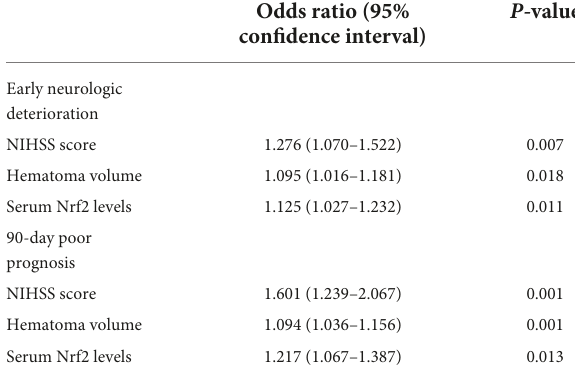
TABLE 4 Results of multivariate analysis for prognostic prediction after acute intracerebral hemorrhage (ICH).